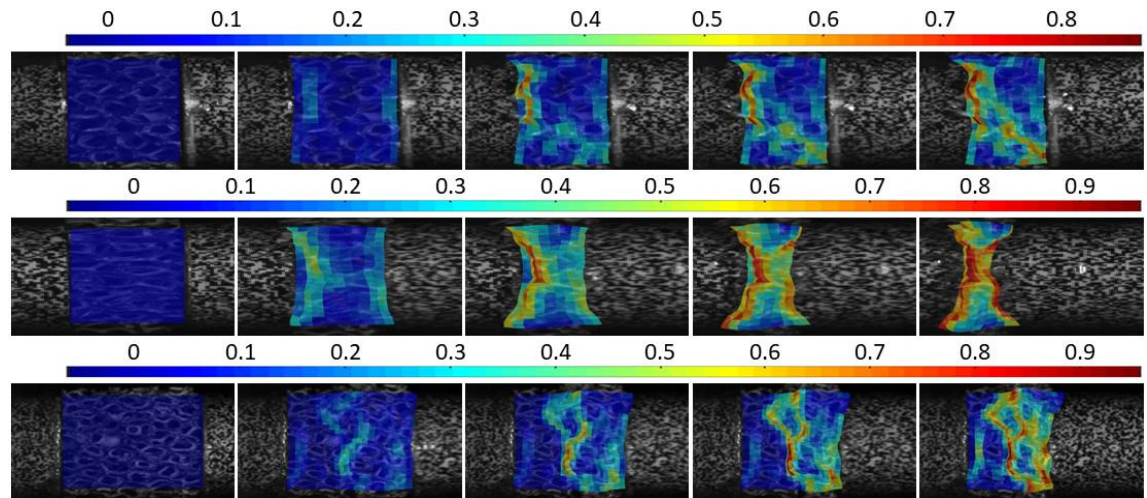
Figure 8. Full-field DIC analysis: in-plane longitudinal strain Top row: Experiment no. 270 , v s = 22 . 1 ms − 1 (low strain-rate, short sample), d = 22 . 4 mm, l = 10 . 1 mm Middle row: Experiment no. 285 , v s = 38 . 1 ms − 1 (high strain-rate, short sample), d = 21 . 9 mm, l = 7 . 5 mm Bottom row: Experiment no. 317 , v s = 43 . 7 ms − 1 (high strain-rate, long sample), d = 21 . 8 mm, l = 18 . 6 mm v s [ms − 1 ] - Striker velocity, d [mm] - Sample diameter, l [mm] - Sample